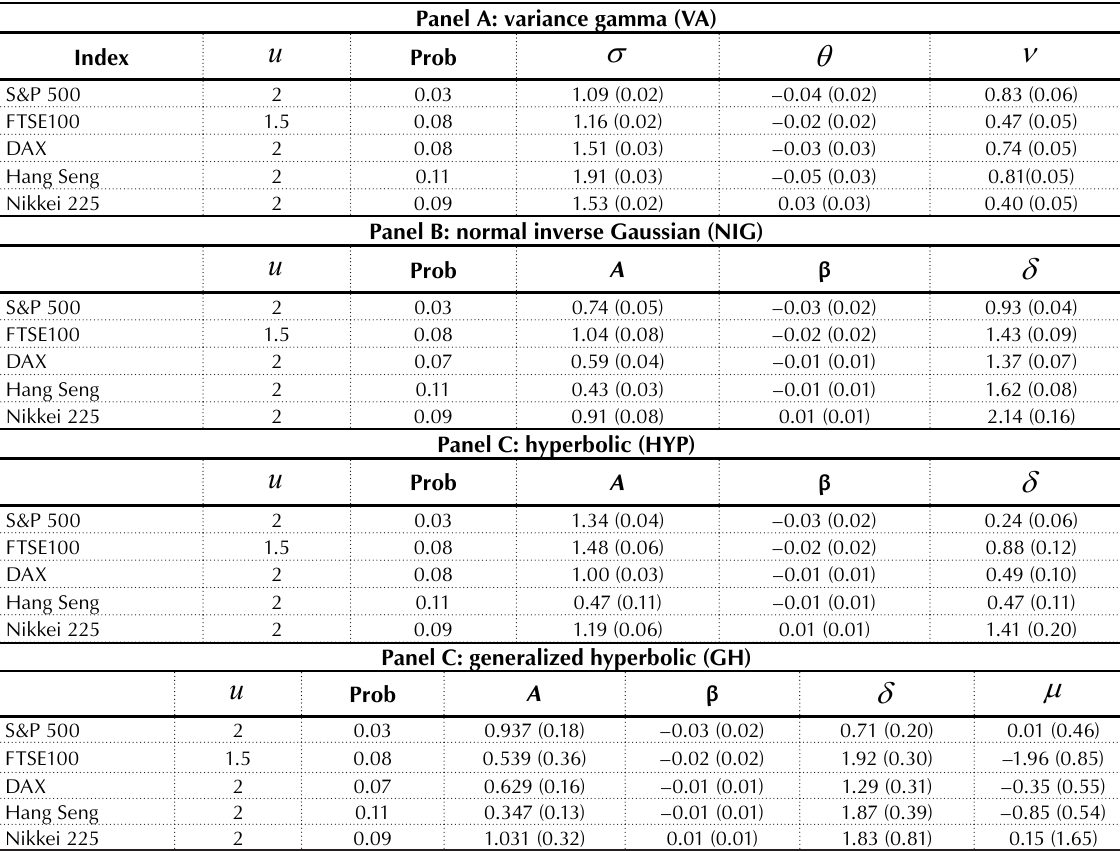
Table 2. Conditional maximum likelihood estimates for futures indexes Panel A: variance gamma